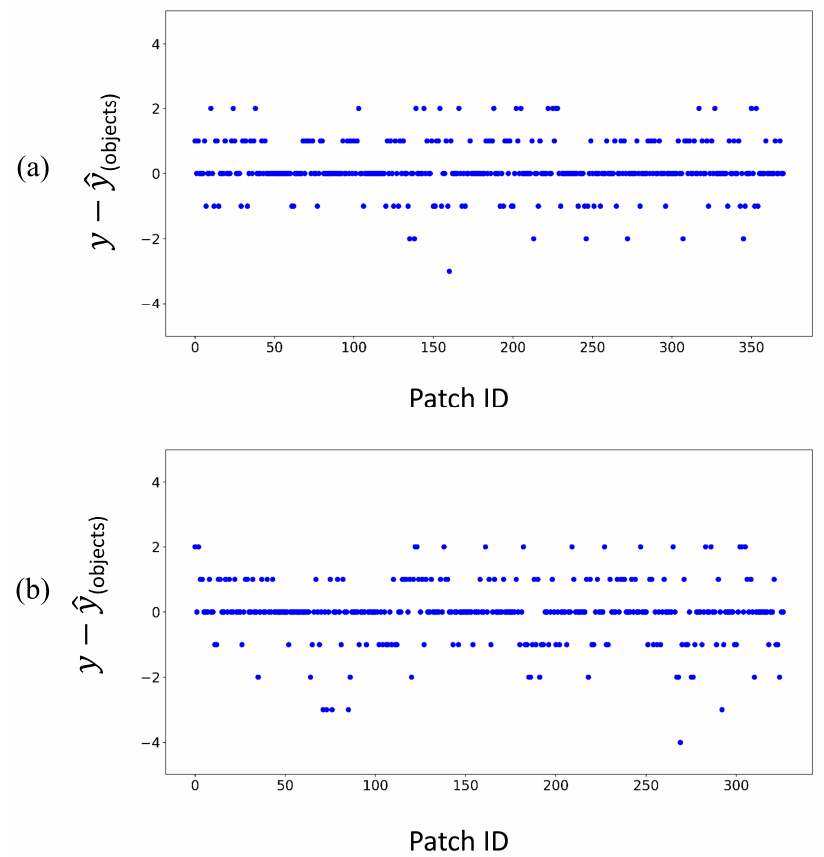
Figure 13. Difference between ground truth and predicted counts for each image patch ( a ) for first and ( b ) second datasets.